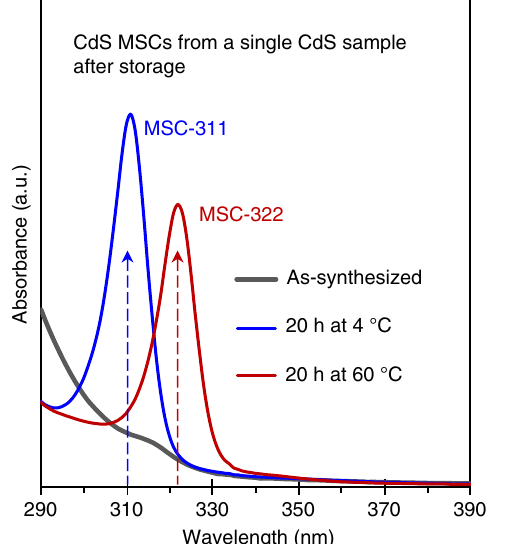
Fig. 1 Single-size CdS MSC-311 and MSC-322 prepared from one reaction mixture. Optical absorption spectra of CdS MSC-311 (blue trace) and MSC- 322 (red trace), collected from a single preheated sample (~20 mg) (gray trace) after 20 h incubation at 4 and 60 °C, respectively. The dispersion solvent used was cyclohexane (3 mL). To prepare the sample, Cd(OA) 2 and SODE were mixed at room temperature with a 4 to 1 feed molar ratio and a S concentration of 30 mmol/kg in ODE; the mixture was heated up to 180 ° C and was held for 20 min. For the optically transparent IP (gray trace) after stored at 4 °C for 20 h, single-size CdS MSC-311 developed, while at 60 °C for 20 h, single-size CdS MSC-322